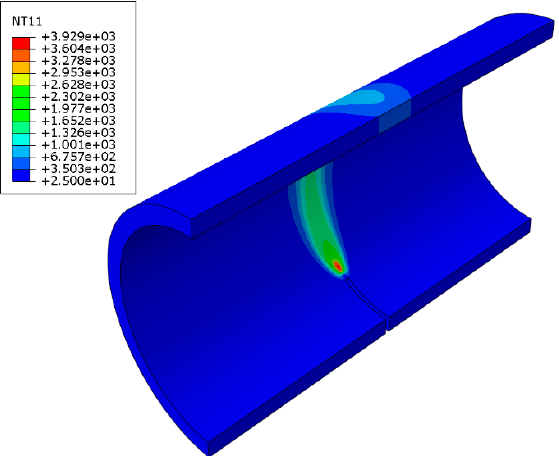
( d ) Figure 8. Full field residual stress distribution; ( a ) axial residual stress—global model, ( b ) axial re- sidual stress—submodel, ( c ) hoop residual stress—global model, ( d ) hoop residual stress—submodel.